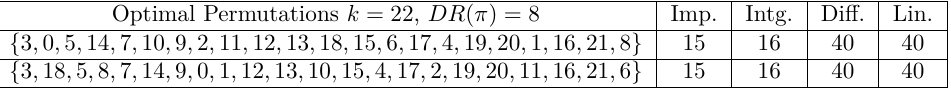
Table 19: Optimal even-odd permutations for k = 22 up to extended pair-equivalence Optimal Permutations k = 22, DR ( π ) = 8 Imp. Intg. Diff. Lin.